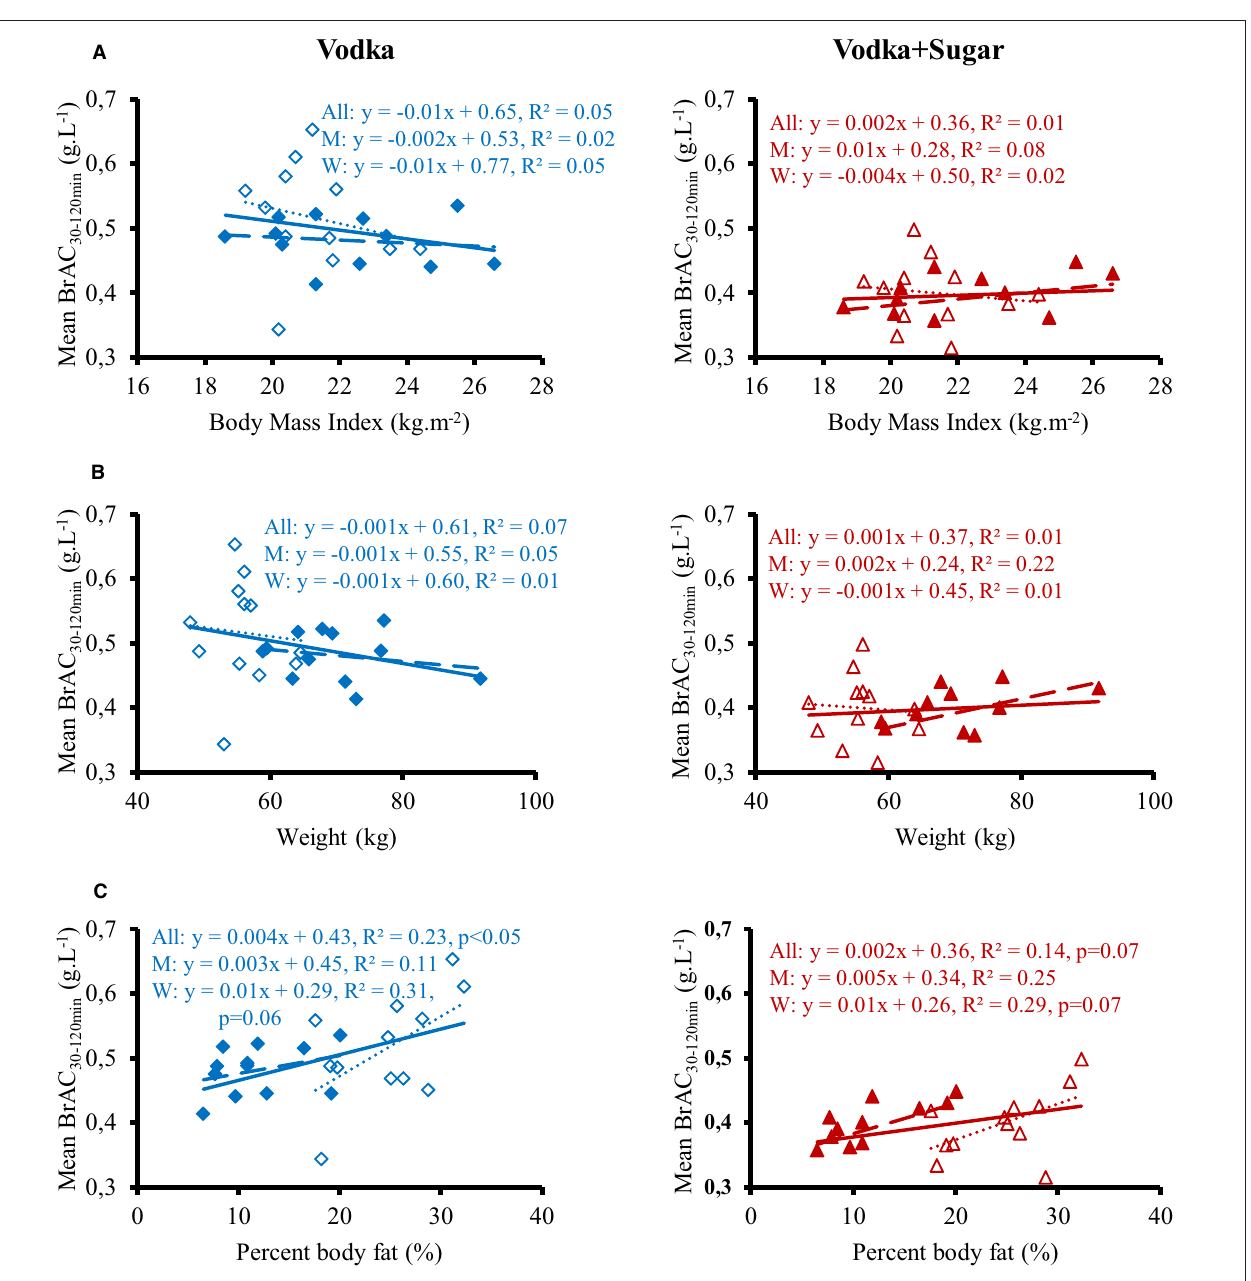
minute of active standing) for all these parameters were similar between all drinks. In the following 7 min, the changes in MBP, CO and TPR were also similar for all those conditions.